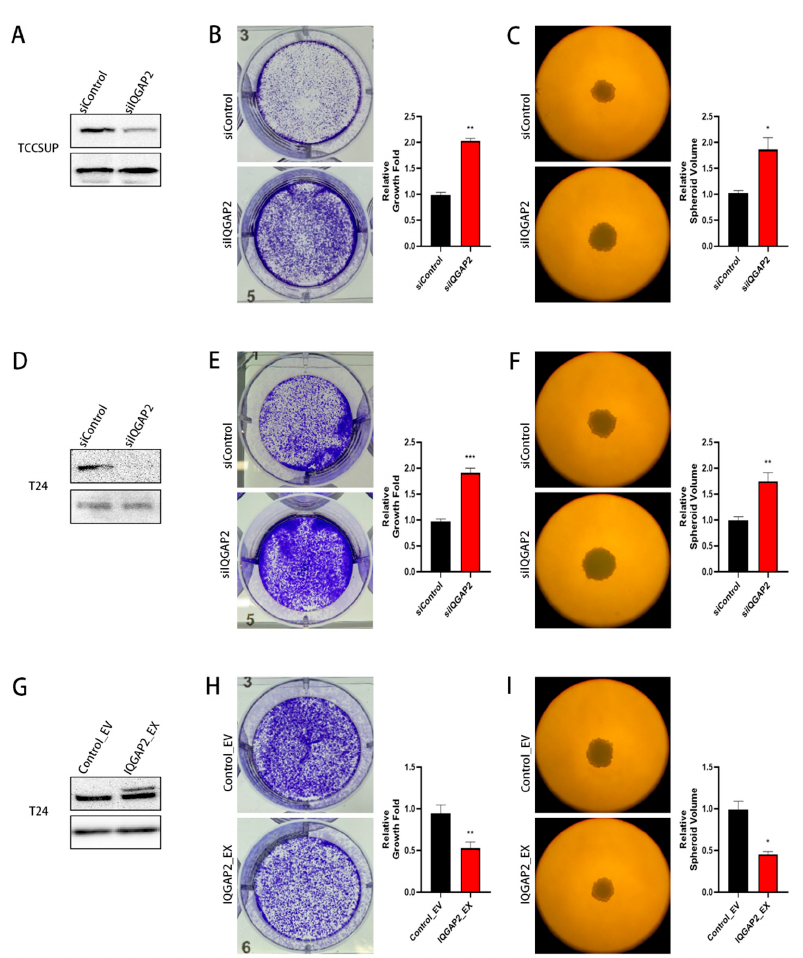
Figure 2. Reduced IQGAP2 promoted cell growth in bladder cancer cell lines. IQGAP2 knockdown in TCCSUP ( A ) and T24 ( D ) was confirmed by Western blot analysis. Knockdown of IQGAP2 in TCCSUP ( B , C ) and T24 ( E , F ) led to significant increase in proliferation in cell monolayer and spheroid growth. IQGAP2 overexpression in T24 ( G ) was confirmed by Western blot analysis. Overexpression of IQGAP2 in T24 ( H , I ) led to significant decrease in proliferation in cell monolayer and spheroid growth. One example in triplicate is shown; bar chart presents the meansof replicates ± SEM from three different experiments; * p ≤ 0.05, ** p ≤ 0.01, and *** p ≤ 0.001; Student’s t -test (two-tailed, unpaired) was used for comparison of means.